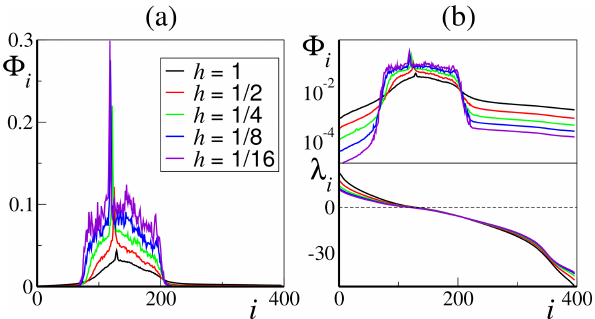
Figure 3. CLV projection onto the slow variables. (a) CLV average projection norm (cid:56) i of the CLVs (see text) as a function of the vec- tor index for K = 36, J = 10 and b = 10 upon varying the coupling constant h . The upper part of (b) is the same as in (a) but in a log- arithmic scale vertical scale; in the bottom part of the panel are the corresponding Lyapunov spectra.